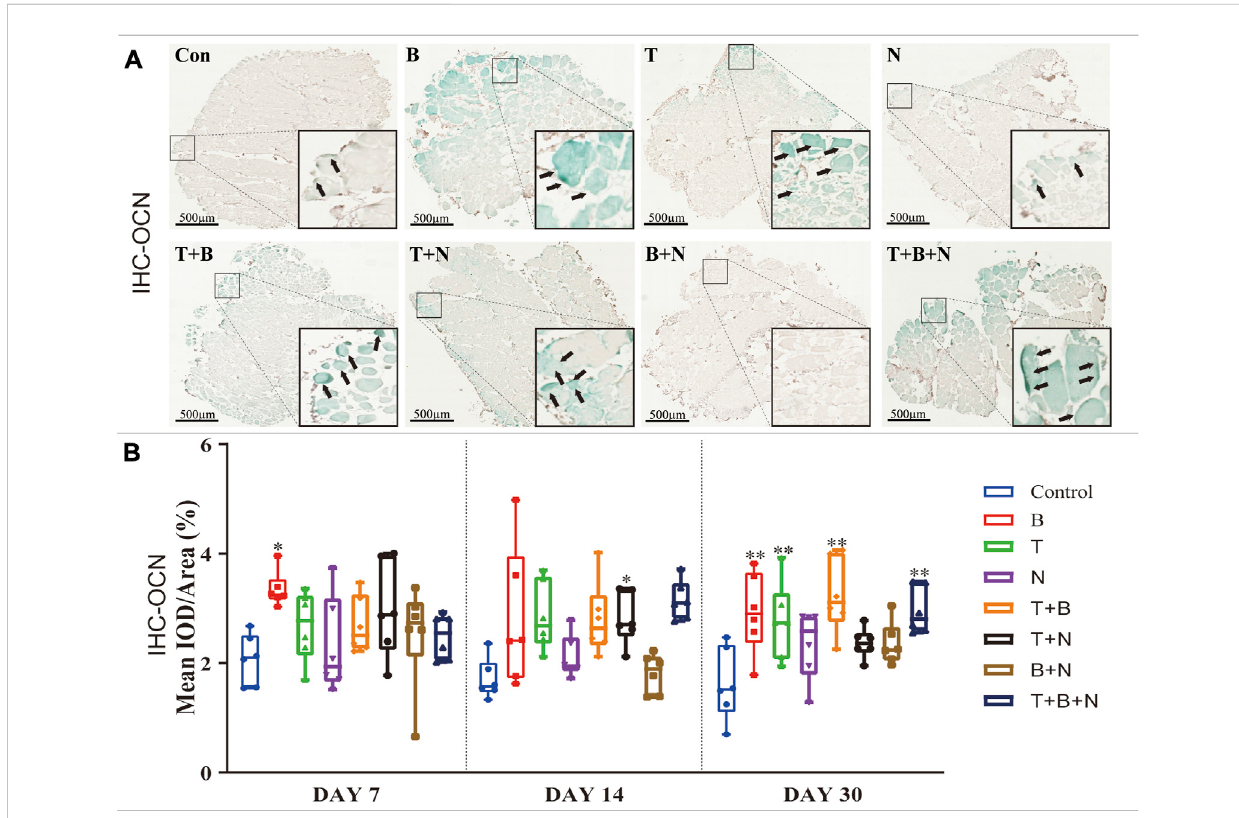
FIGURE 6 The staining results of the OCN antigen in the IHC in each group. (A) Staining results on day 30; the positive staining color was green (marked by black arrows). (B) Histomorphometrical assessment; the result was shown as Mean IOD/Area. Control group vs. stimulated groups at 7, 14, and 30 days; the asterisks indicate that the stimulated group is statistically signi fi cant compared to the control group. (Magni fi cation: ×40; n = 6; * p < 0.05; ** p < 0.01; *** p <